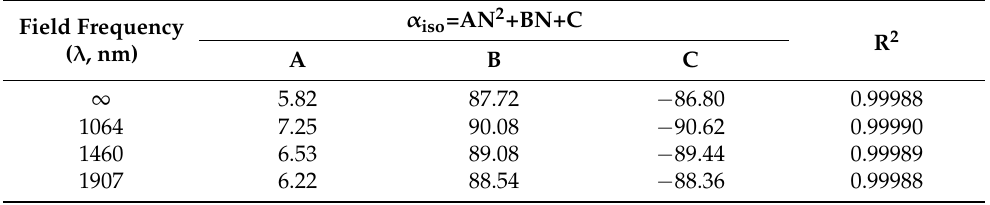
Table 1. The extrapolation formula of the polarizability of [2N,2N]CNB under different external fields. Field